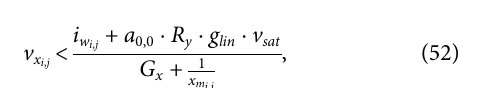
FIGURE12| CellSDP,emergingforthe fi xedcircuitparametersettingfrom Table1 ,under i w for